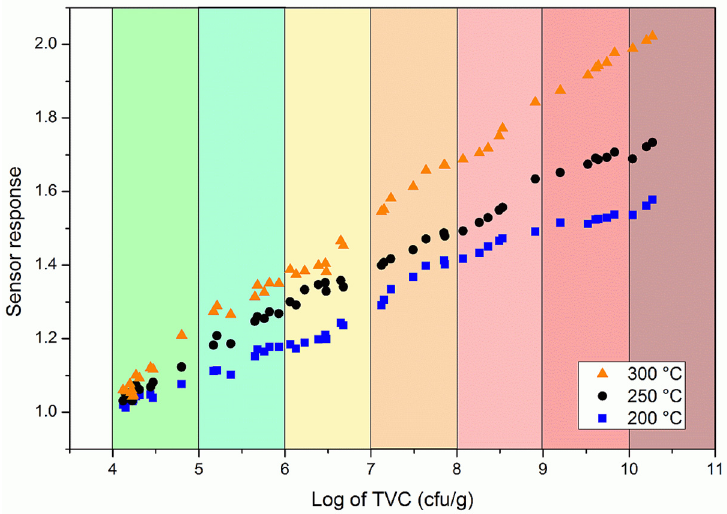
Figure 6. Double-blind measurements of the sensor response as a function of the total viable count in rainbow trout samples.